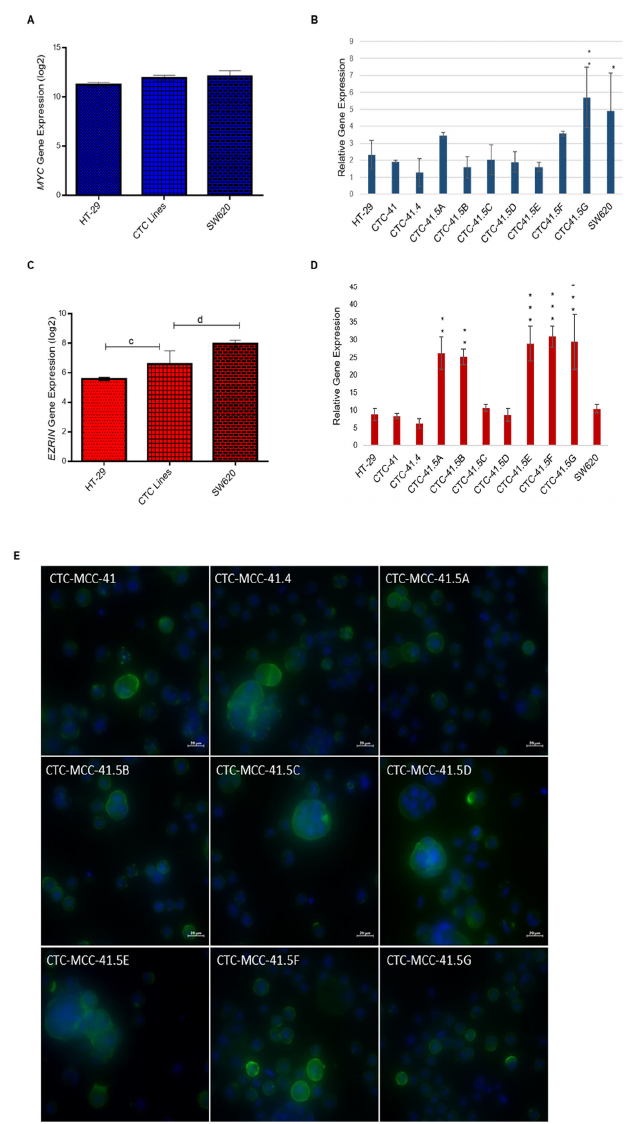
3.2. SIX1 Targets Are Expressed in All Nine Colon CTC Lines SIX1 activates the transcription of potent oncogenes and stem cell regulators, such as c-MYC and ezrin, that have a vital role in tumor invasion and signal transduction in many cancers [28–32]. MYC has an important role in cell proliferation, differentiation, survival, apoptosis, cancer stemness, and in drug resistance in colorectal cancer stem cells [33]. Comparison of MYC expression in CTCs, HT-29, and SW620 cells showed that it was 1.8-fold (log2) upregulated in CTCs compared with HT-29 cells (Figure 2A). Moreover, all nine CTC lines expressed MYC, but its relative expression was higher in CTC41.5A, cytoplasm, particularly near the cell membrane of all CTC cell lines (Figure 2E). Alto- CTC41.5F, and particularly in CTC41.5G cells, as well as in SW620 cells, than in the other gether, these data indicate that in our CTC lines, the SIX1 target genes MYC and EZR were upregulated without the need of SIX1 activation. CTC lines and in HT-29 cells (Figure 2B).